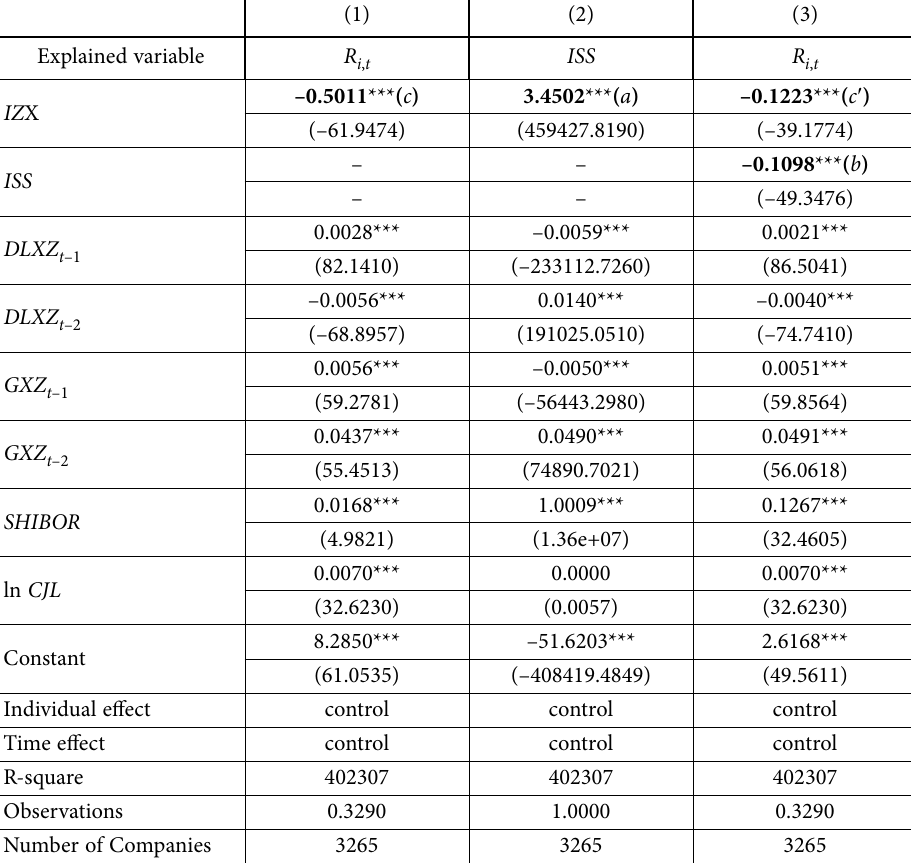
Table 12. Mediating effect test of information infection (1)